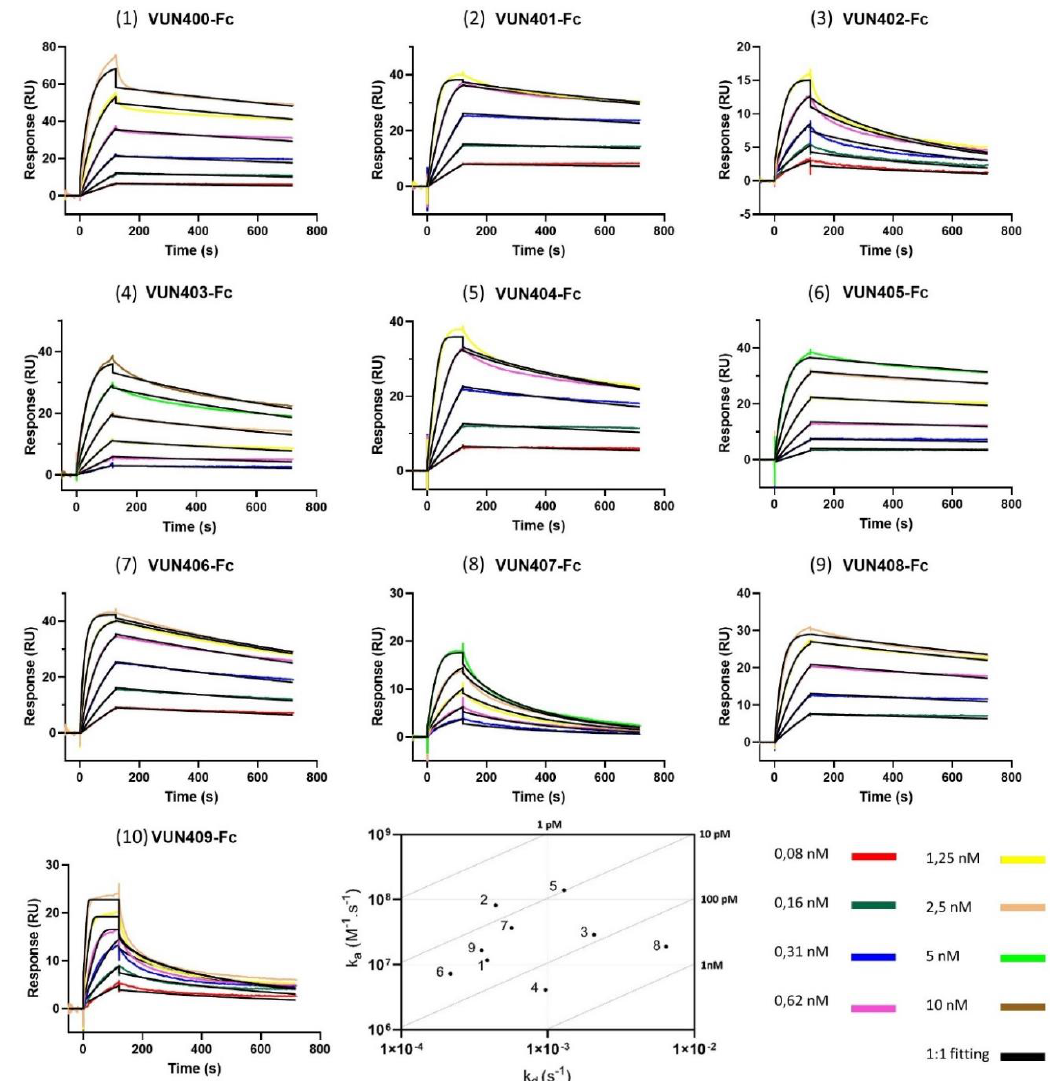
Figure 3. Sensorgrams of the binding curves (colored lines) and the fitted data (black lines) of the ten different nanobody-Fcs (Nb-Fcs) binding to histidine-tagged CXCR4 immobilized on an NTA surface. Concentrations of the injections are given in the legend. All experiments were carried out on a Biacore T200, and the data were fitted to the 1:1 Langmuir model using Biacore T200 Evaluation Software 3.1. An on-off rate map is included depicting the kinetic results of all Nb-Fcs (excluding VUN409-Fc), the oblique lines indicate the iso-affinities (K D ).